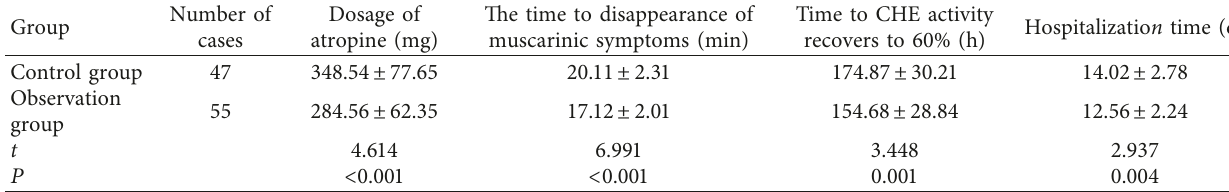
Table 4: Comparison of relevant indicators of the clinical effect ( n , x ± s ).